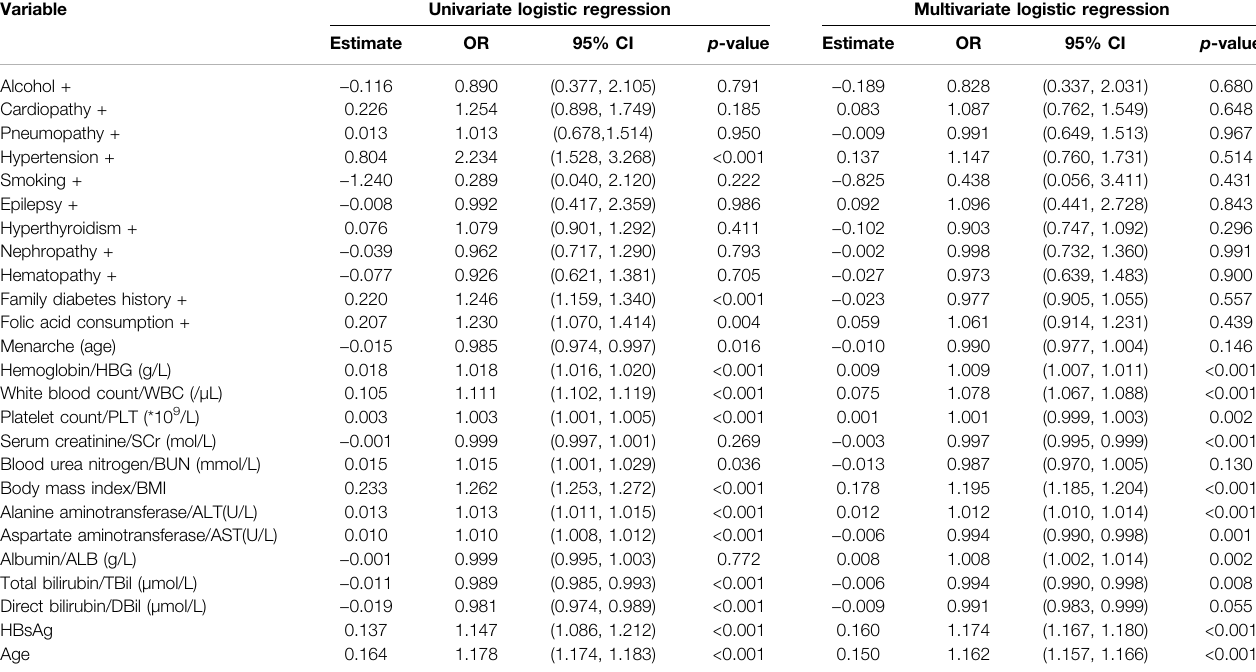
TABLE 2 | Univariate and multivariate logistic regressions in GDM populations. Variable Univariate logistic regression Multivariate logistic